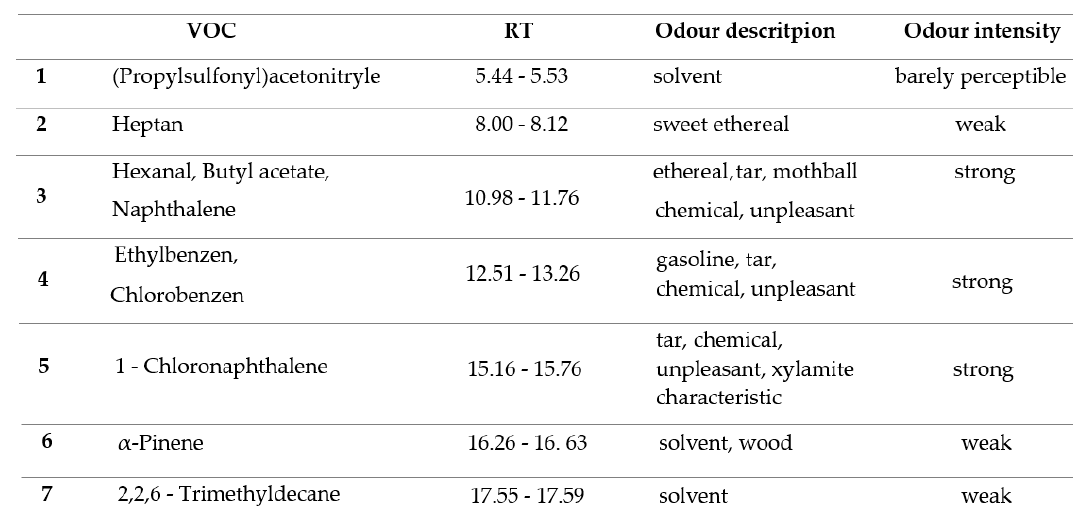
Figure 7. GC-MS chromatogram with olfactory detection port signals, categorizing the intensity of odors as “barely perceptible” (yellow on the spectrum), “weak” (green), and “strong” (red). The table reports the identified odor signals according to the peak number.